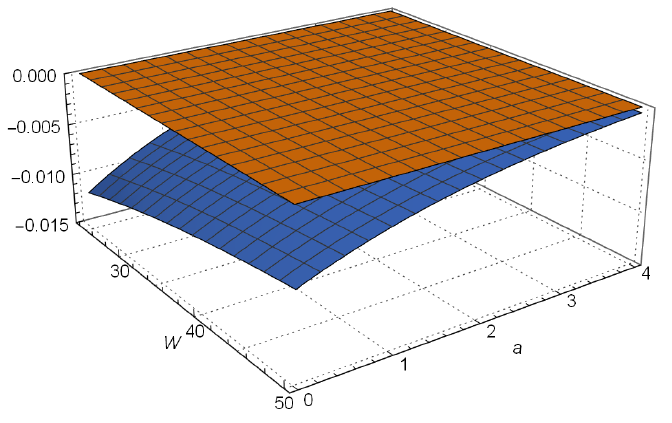
Figure 3. DU ( W , a )